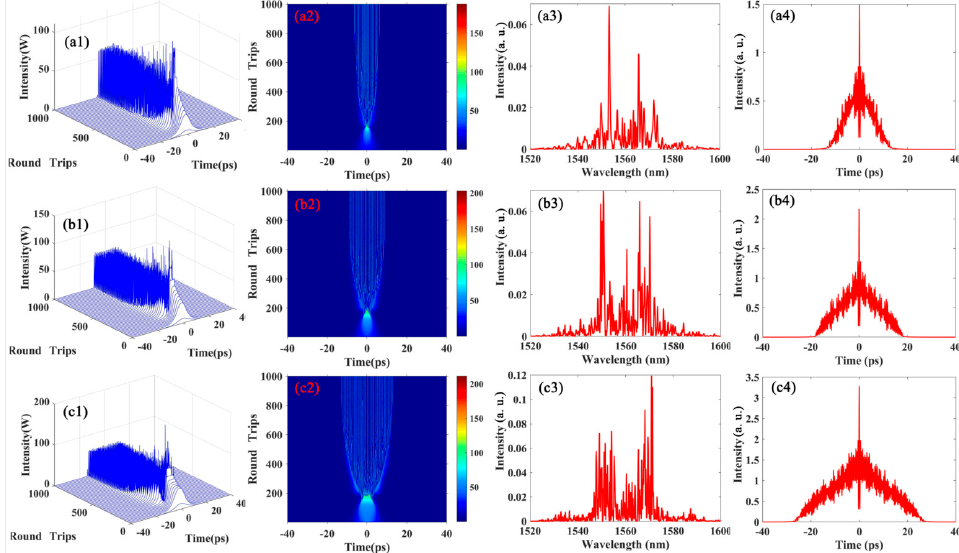
Figure 10. Numerical simulation of NLP output pulse characteristics as a function of pump power using the BL-CNT SA setup. ( a1 )–( c1 ) the simulated envelope evolution of the NLP pulse at the gain coefficient g 0 values of 70, 100, and 150 W − 1 ; ( a2 )–( a4 ) the simulated time evolution, AC trace and optical spectrum at g = 70 W − 1 ; ( b2 )–( b4 ) g = 100 W − 1 and ( c2 )–( c4 ) g = 150 W − 1 , respectively.